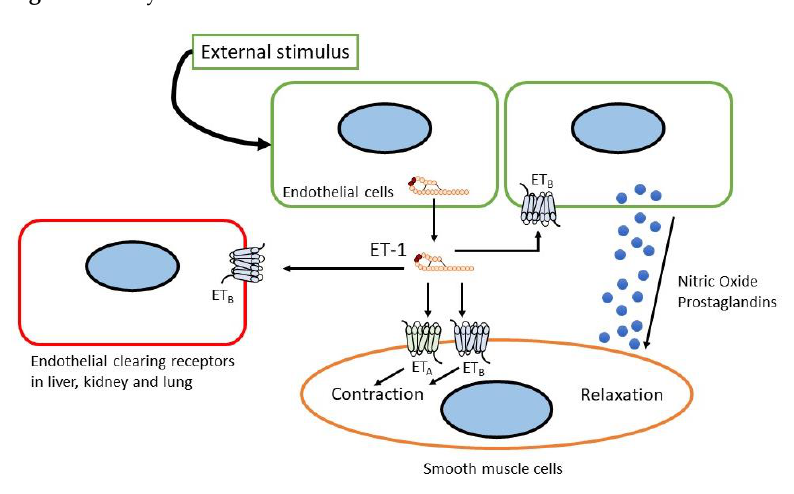
Figure 2. Sites and mechanism of action of endothelin.